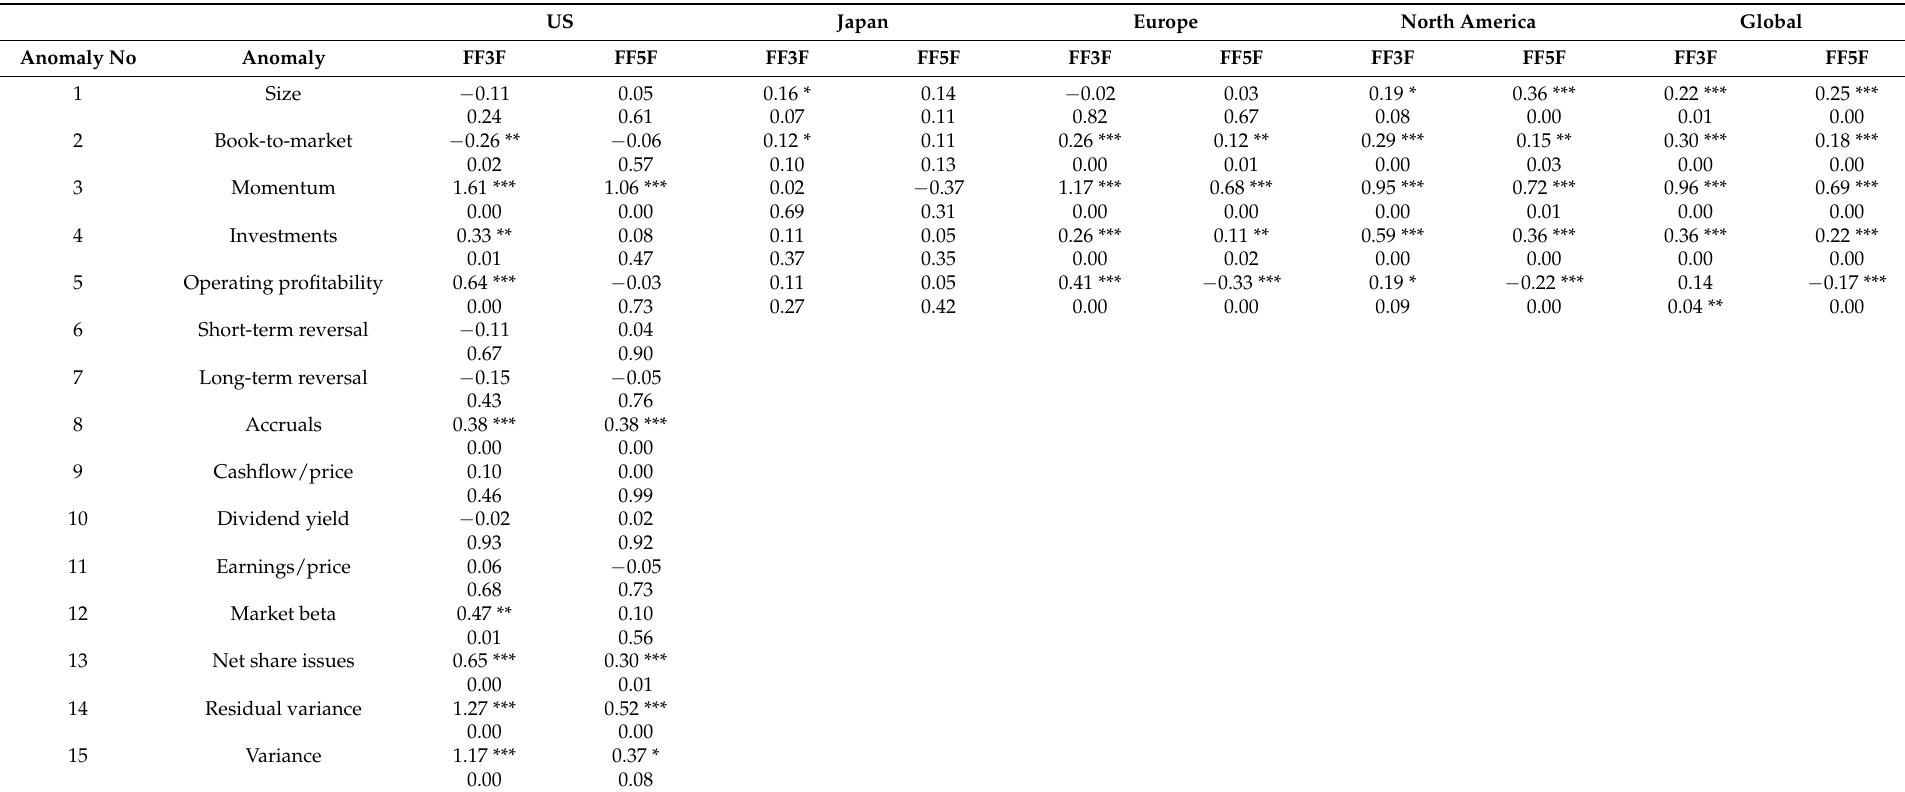
Table 6. Regression results: constant coefficient (alpha) in the FF3F and FF5F